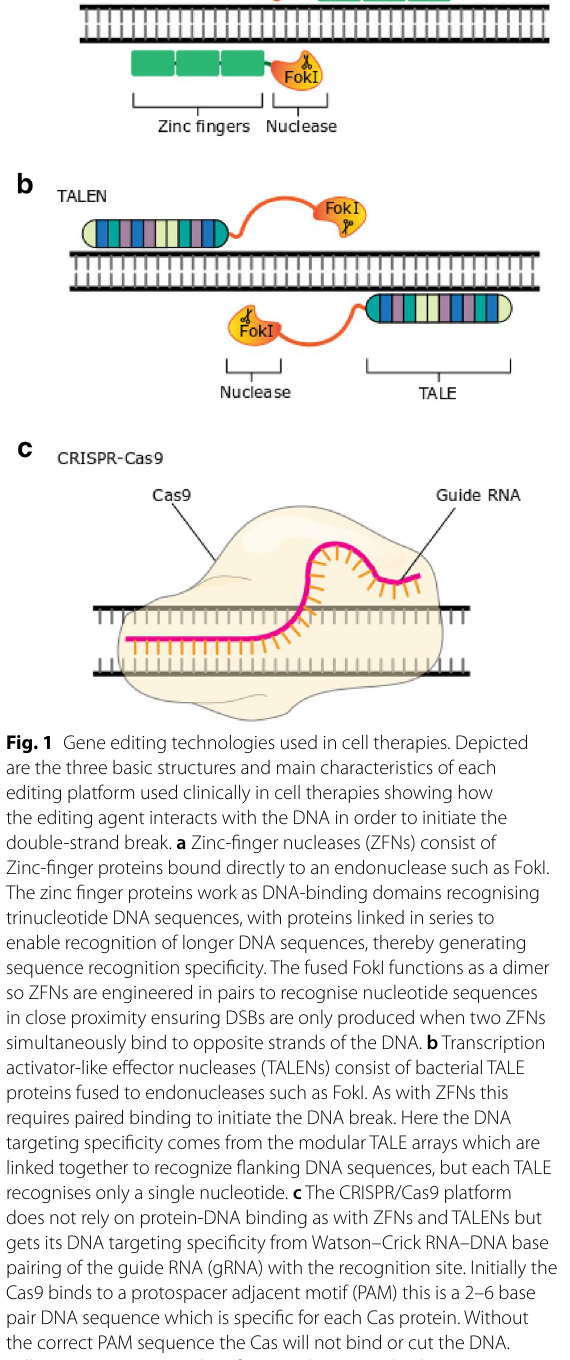
trinucleotide DNA sequences, with proteins linked in series